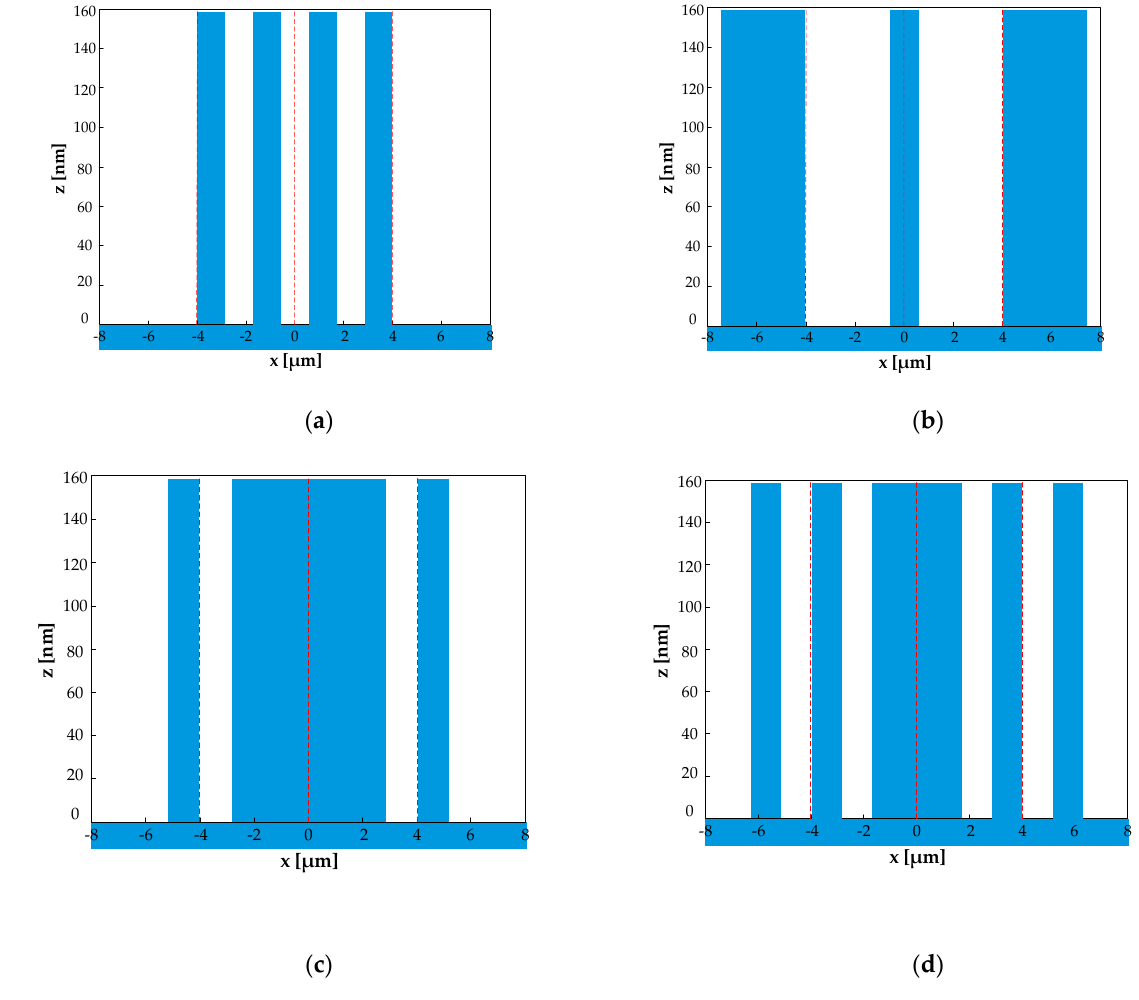
Figure 20. The structures of AH74 and AH74_opt in one period. ( a ) AH74, ( b ) AH74_opt1, ( c ) AH74_opt2, ( d ) AH74_opt3. Table 4. The structure parameters of AH74, AH74_opt1, AH74_opt2, AH74_opt3.